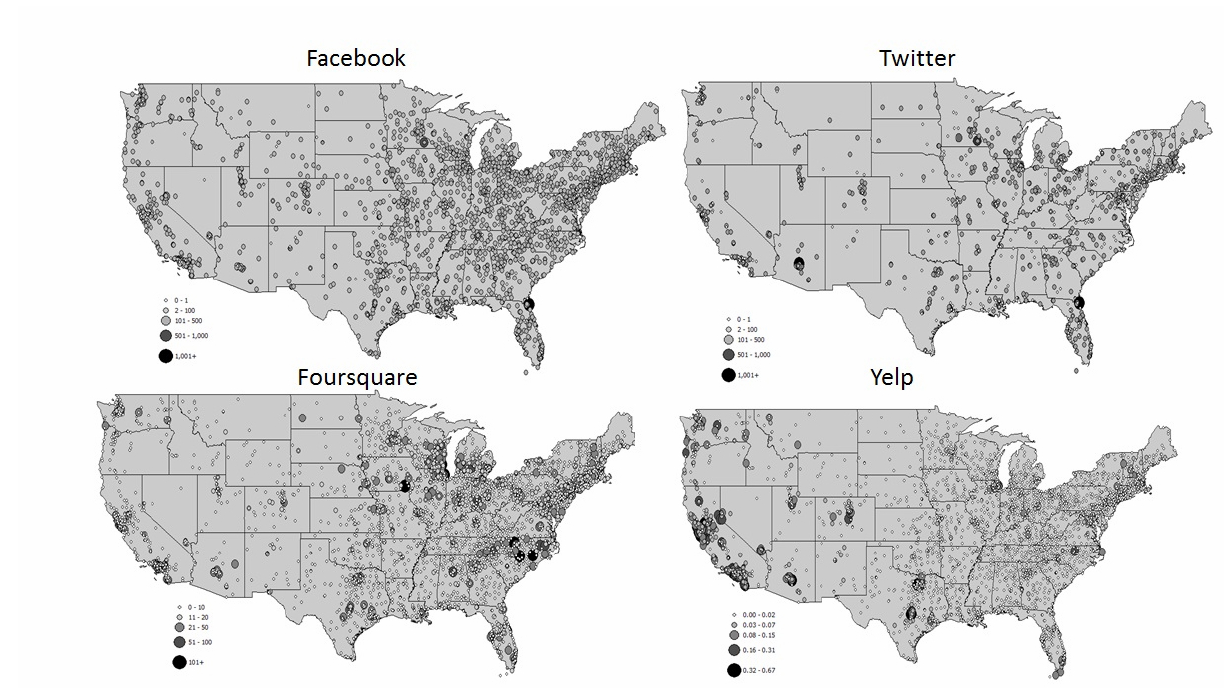
Figure 2. Maps of social media utilization for hospitals adjusted by bed